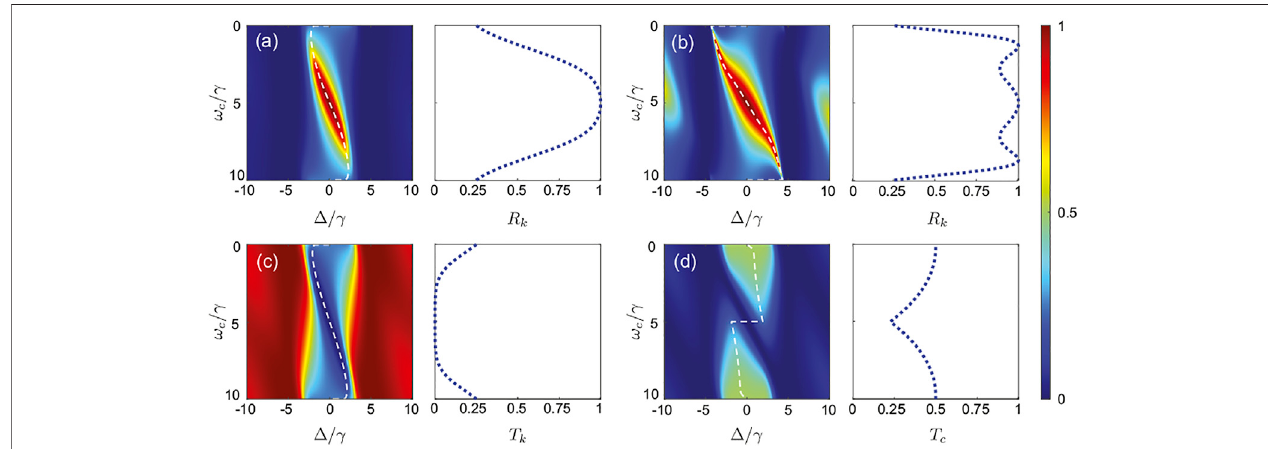
FIGURE 2 | Scattering rates. (A) , (C) and (D) depict the re fl ectance, transmittance, and frequency conversion rate of the incident ω k photon, respectively, as a function of the normalized detuning Δ / γ and the substable state frequency ω c / γ for γ T = 0.2 π . (B) shows the re fl ectance for γ T = 3 π . The white dashed curves in the colormaps depict trajectories of max [ R k ( Δ )], min [ T k ( Δ )], and max [ T c ( Δ )] versus ω c / γ , respectively, while the right plots show the maximum or minimun value of the corresponding rate versus ω c / γ